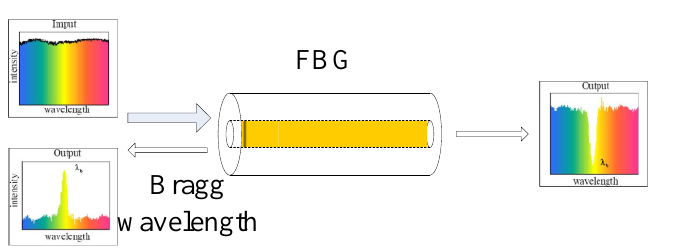
Figure 2. Functional principle of an